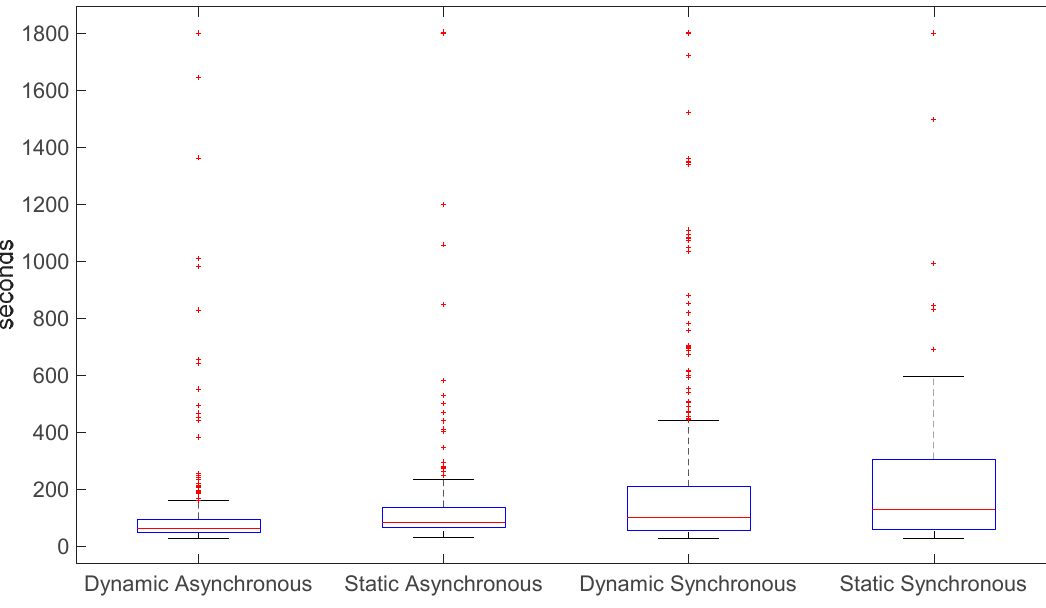
Figure 4. Boxplot of the methods over the set E